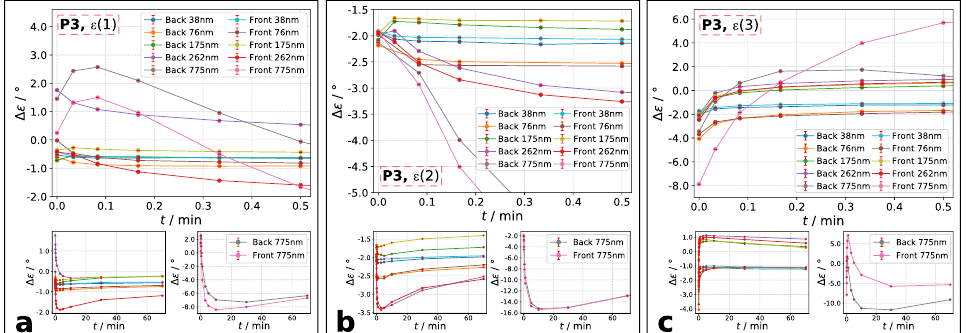
Figure 10. Polymer P3 : ∆ (cid:101) = (cid:101) a,t − (cid:101) a,i during the first 30 s. Ellipticity combination is: ( a ): (cid:101) ( 1 ) , ( b ): (cid:101) ( 2 ) , and ( c ): (cid:101) ( 3 ) . Denotation: main plot: ∆ (cid:101) at exposure time up to 30 s; left small plot: ∆ (cid:101) for films with up to d = 262nm. right small plot: ∆ (cid:101) for d = 775nm. The combination of (cid:101) ( n ) is labelled in each main